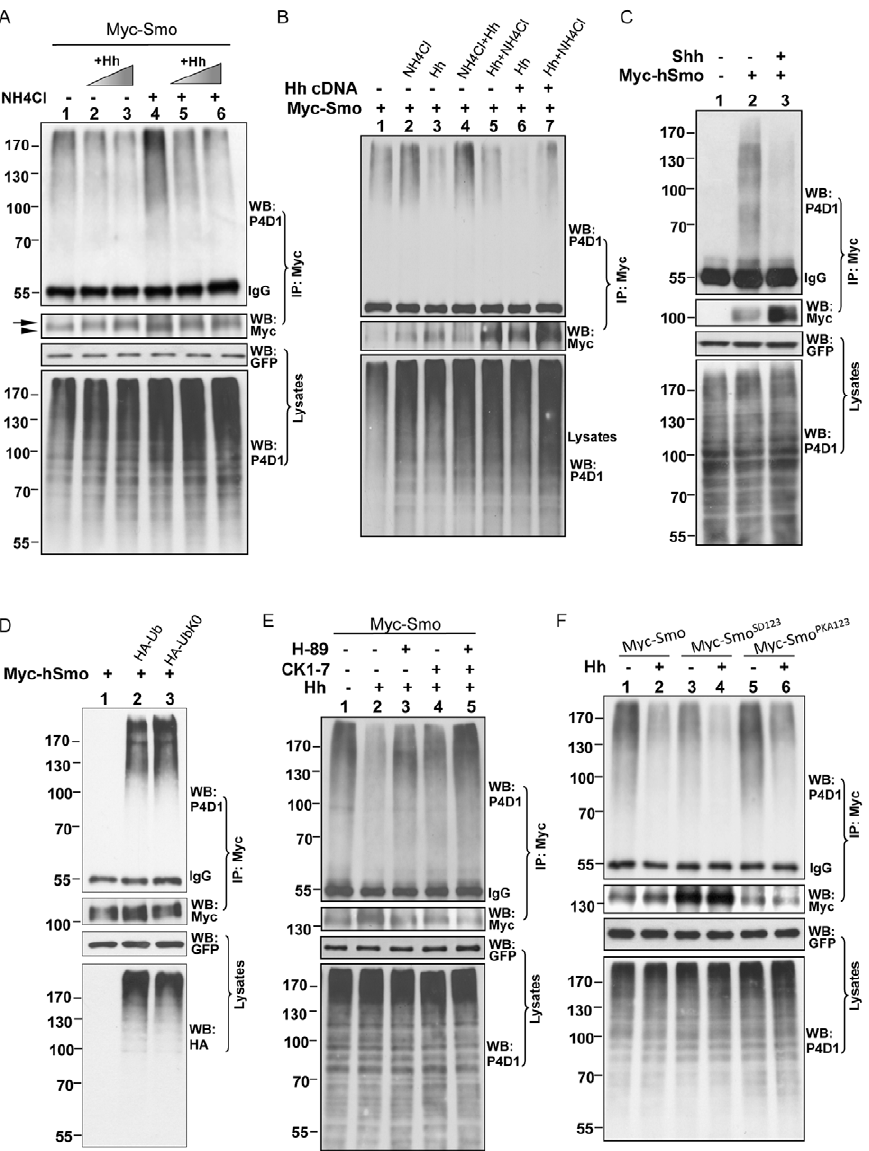
Figure 3. Smo ubiquitination is regulated by Hh and phosphorylation. (A) S2 cells were transfected with Myc-Smo and treated with 30% (lanes 2 and 5) or 60% (lanes 3 and 6) of Hh-conditioned medium or control medium (lanes 1 and 4), followed by treatment with or without NH 4 Cl. Cell extracts were immunoprecipitated and a Western blot was performed with the indicated antibodies. IgG served as a loading control and GFP was used as the transfection control. The arrow indicates hyperphosphorylated forms of Smo and the arrowhead indicates hypophosphorylated and unphosphorylated forms. (B) Sequential treatments with Hh and lysosomal inhibitor induce differential ubiquitination of Smo. S2 cells were transfected with Myc-Smo and treated with either Hh or the lysosomal inhibitor NH4Cl alone, or in combinations of Hh and NH4Cl treatment, followed by immunoprecipitation and Western blot with the indicated antibodies to examine the ubiquitination levels of Smo. The following treatments were performed: lane 1, control; lane 2, treatment with NH4Cl at a final concentration of 10 mM for 24 h; lane 3, treatment with 60% HhN- conditioned medium for 24 h; lane 4, treatment with NH4Cl at the concentration of 10 mM for the first 6 h, then adding 60% of the volume of HhN- conditioned medium, keeping NH4Cl at a final concentration of 10 mM for 18 h; lane 5, treatment with 60% volume of HhN-conditioned medium for the first 6 h, then adding NH4Cl at final concentration of 10 mM, keeping 60% volume of Hh medium for 18 h; lanes 6 and 7, HhN cDNA was cotransfected to achieve higher levels of Hh treatment. Consistently, Hh treatment down-regulates (lane 3, top panel) whereas NH4Cl treatment up- regulates (lane 2, top panel) Smo ubiquitination. However, Hh treatment down-regulates Smo ubiquitination before NH4Cl treatment (lane 5, top panel), but not after NH4Cl treatment (lane 4, top panel). The further down-regulation of Smo ubiquitination by Hh was achieved by cotransfecting Hh cDNA (lane 6, compared to lane 3). (C) NIH3T3 cells were transfected with Myc-hSmo and treated with or without recombinant Shh. Shh induced a marked decrease in hSmo ubiquitination (lane 3). (D) HEK293T cells were transfected with the indicated constructs and cell extracts were immunoprecipitated and blotted with the indicated antibodies. Cell lysates were also subjected to direct Western blot to examine the HA-tagged Ub expression. GFP served as transfection and loading control. Human Smo had a similar multi-mono ubiquitination pattern compared to fly Smo. (E) S2 cells transfected with Myc-Smo were treated with Hh-conditioned medium or control medium in combination with a PKA inhibitor (H-89) or CK1 inhibitor (CK1-7). Immunoprecipitation and Western blots were performed with the indicated antibodies. The levels of ubiquitinated Smo were increased by inactivating kinases. (F) S2 cells were transfected with wild-type, phospho-mimetic, or phospho-deficient Smo followed by treatment with Hh-conditioned medium or control medium. The same ubiquitination assay was carried out to examine ubiquitinated Smo with IgG and GFP serving as controls. doi:10.1371/journal.pbio.1001238.g003 PLoS Biology |